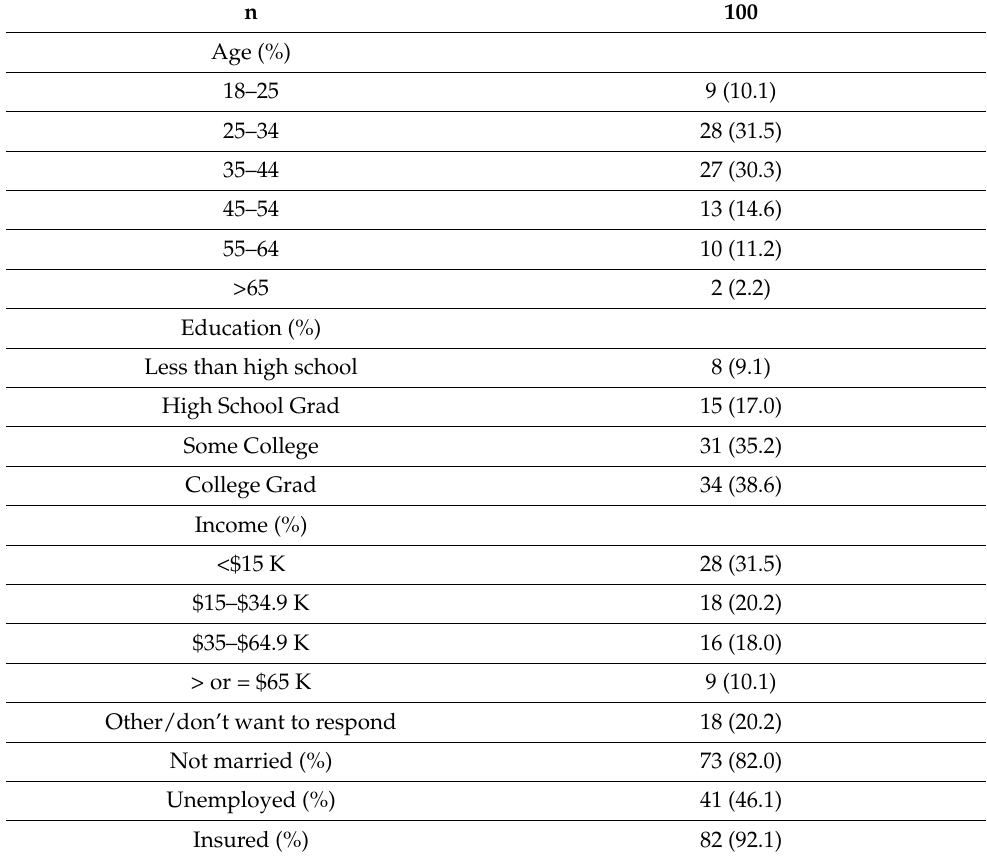
Table 1. Baseline Demographics (N = 130). n